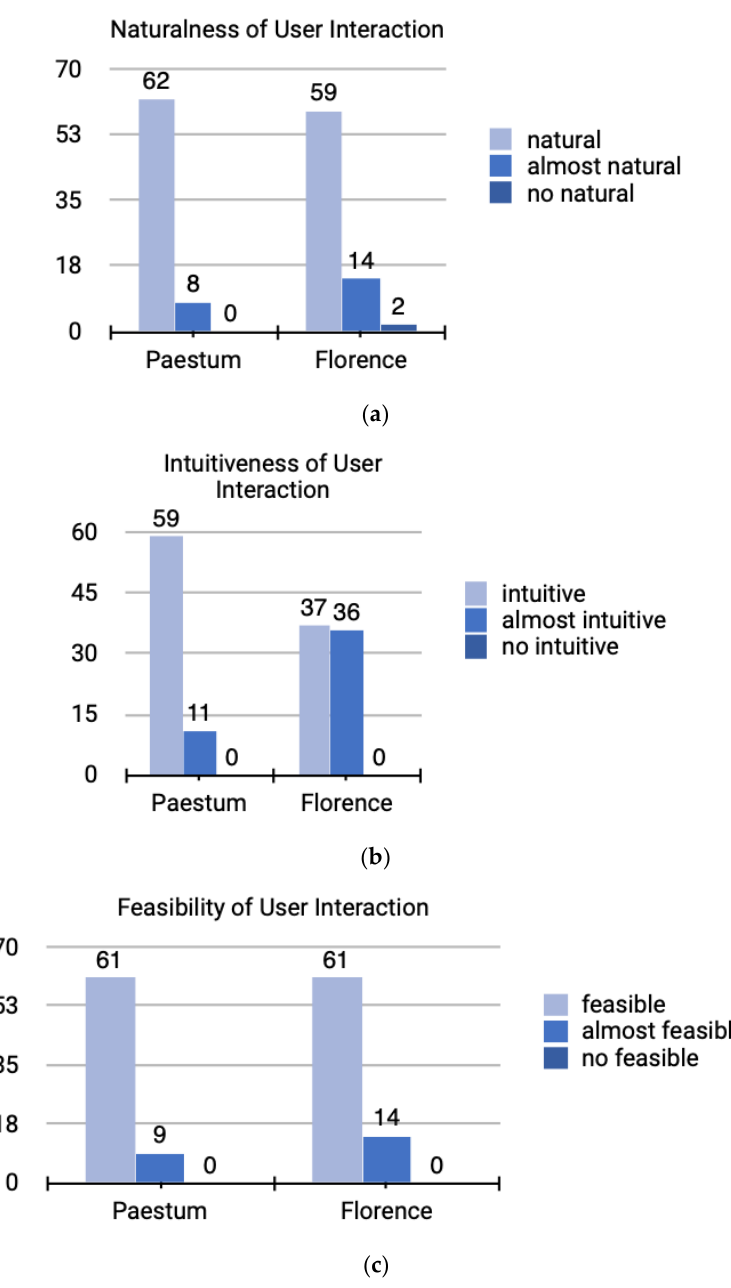
Figure 16. Preferences out of 70 + 75 responses to the question “ How did you find the interaction into the VR experience ?”. ( a ) Chart about the naturalness of the user–system interaction; ( b ) chart about the intuitiveness of the user–system interaction; ( c ) chart about the feasibility of the user–system interaction.